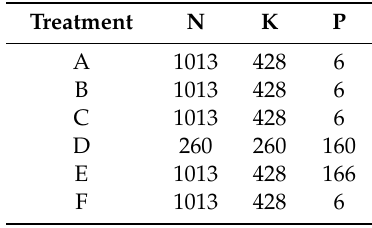
Table 9. Total nutrient (kg ha − 1 ) supply to paddy field from TWW and fertilizers. Treatment